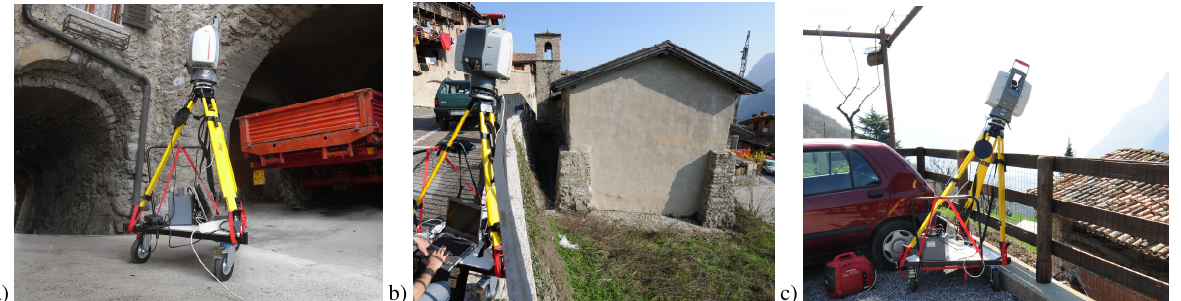
Figure 10: The laser scanner on the home-built trolley (a). Not-accessible areas which required to place the surveying instrument is difficult positions (b,